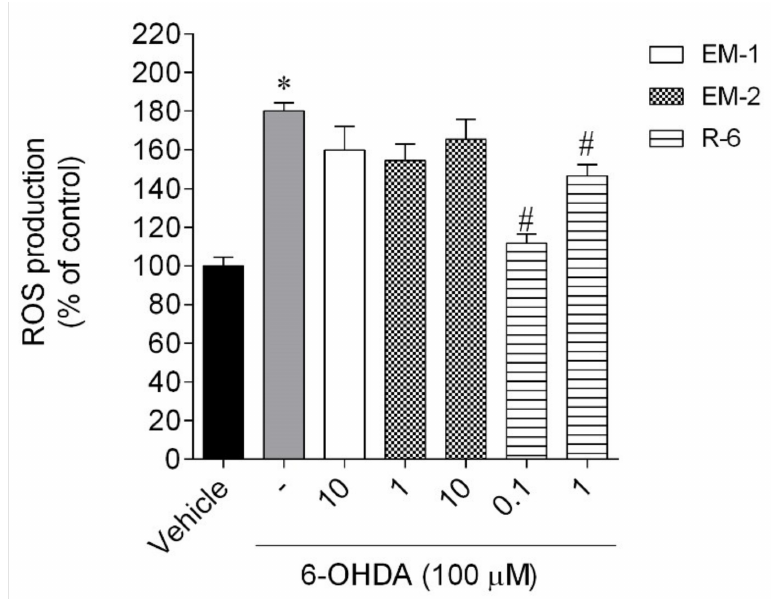
Figure 7. ROS production of SH-SY5Y cells treated with 6-OHDA in the presence/absence of peptides (0.1–10 µ M, 6 h). The values in each column represent the mean ± standard error of the mean (SEM) of 3 or 4 independent experiments. Symbols represent significant differences (ANOVA, Dunnett’s test, p < 0.05) when compared to: * vehicle and # 6-OHDA. (-) 6-OHDA.